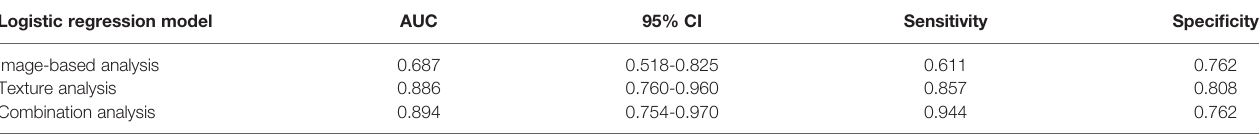
TABLE 4 | ROC analysis of image-based analysis, texture analysis, and the combination analysis. Logistic regression